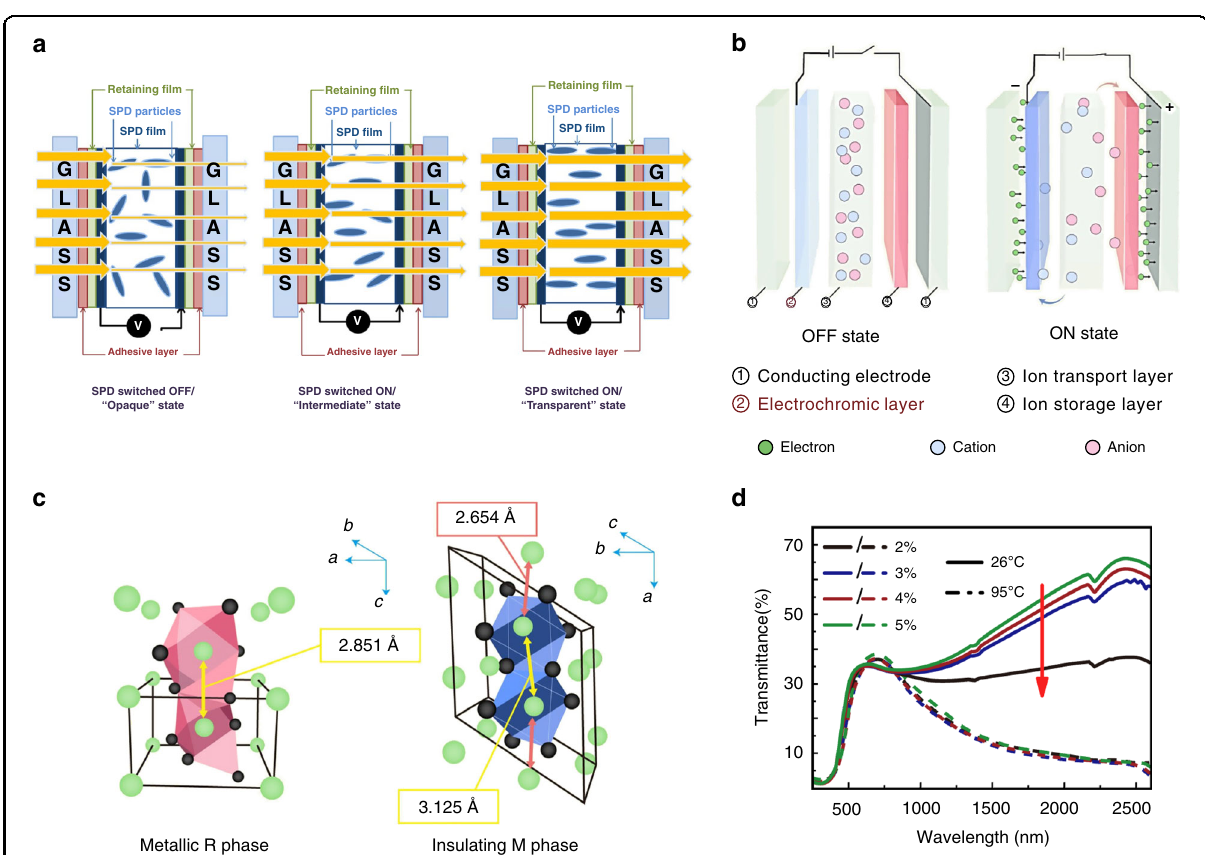
Fig. 1 Diagram of the principles of different types of light protection technology. a Schematic of the dimming principle of SPD smart windows that require power to maintain the transparent state. Reproduced with permission from ref. 208 . Copyright2019, Elsevier. b Schematic of the relationship between the morphology of EC materials and response time. c Schematic of the phase transition of VO 2 crystals from a high-temperature metallic tetragonal phase R to a low-temperature insulating monoclinic phase M 209 . d Transmittance spectra of VO 2 fi lms prepared with different oxygen fl ow ratios. c, d Reproduced with permission from ref. 210 . Copyright 2018,